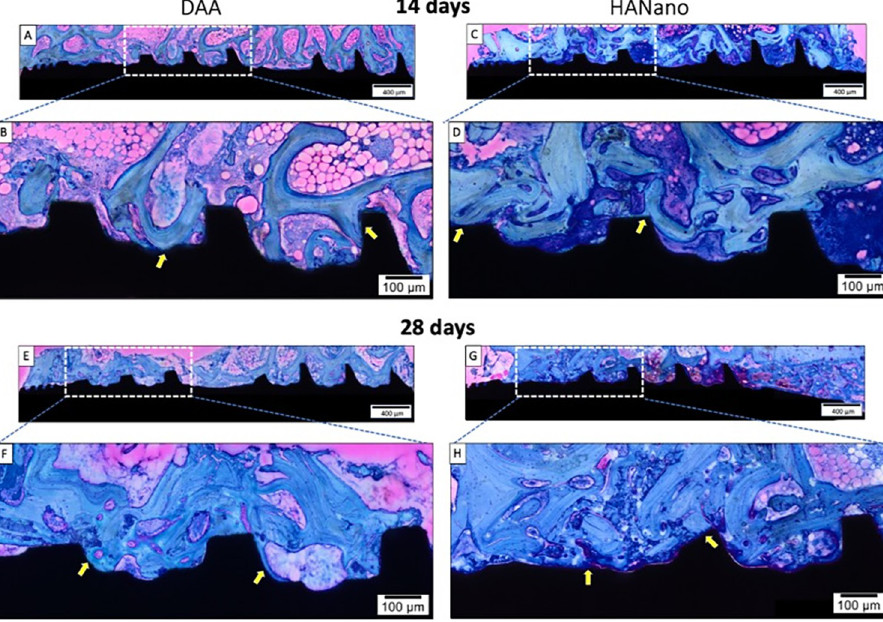
Fig 6. Representative photomicrographs of the implants at 14- and 28-days post-implantation. The dashed area is the square magnification. (A+B) DAA and (C+D) HAnano groups 14 days post-implantation. (E+F) DAA and (G+H) HAnano groups 28 days post-implantation. Staining used toluidine blue and acid fuchsin. Scale bar: 400 μ m, A, C, E, and G; 100 μ m, B, D, F, and H.